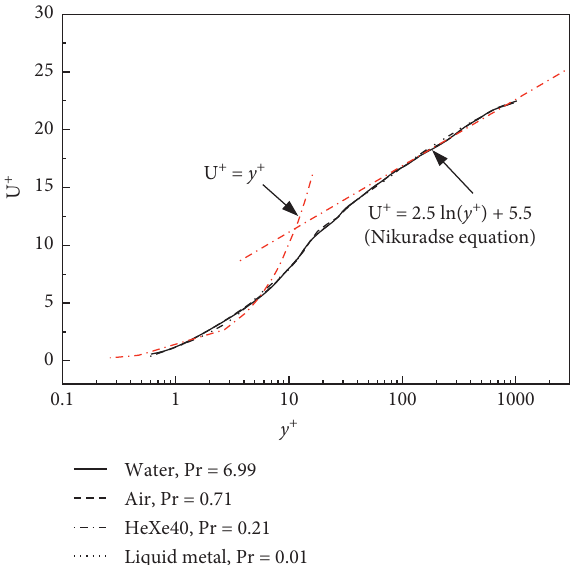
Figure 9: Velocity profiles of fluids with different Prandtl numbers.